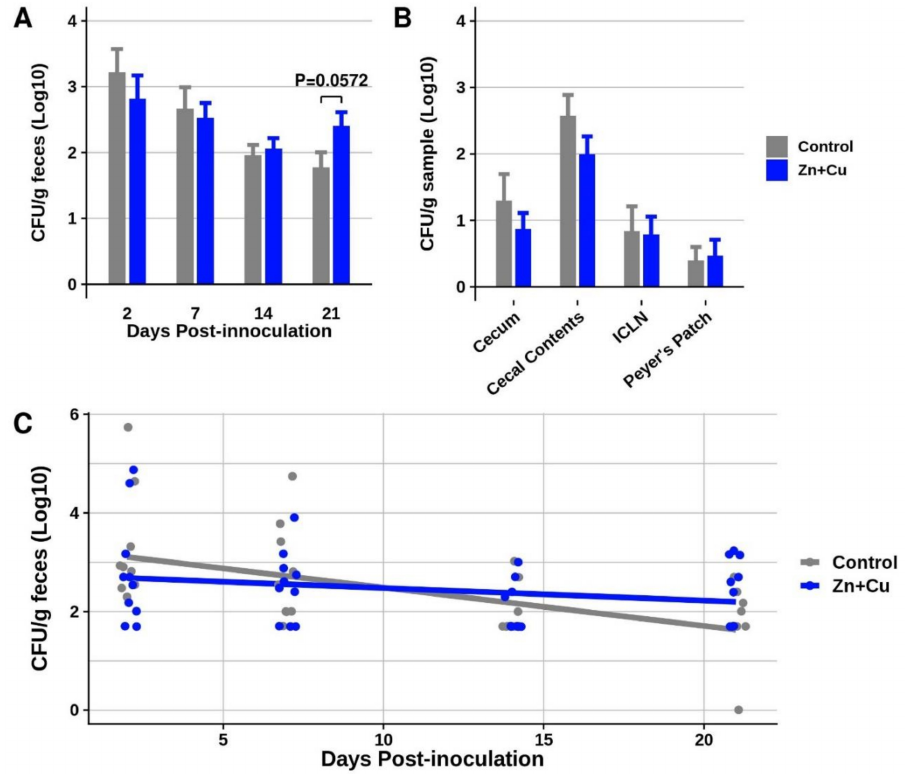
Figure 3. Swine fecal shedding and tissue colonization of serovar I 4,[5],12:i:- following inoculation in pigs with and without in-feed Zn + Cu supplementation. ( A ) Swine fecal shedding of SX 240 at days 2, 7, 14, and 21 following inoculation. ( B ) Swine tissue colonization of SX 240 at day 21 following inoculation. ( C ) Linear mixed model of swine fecal shedding of SX 240 over a 21-day period following